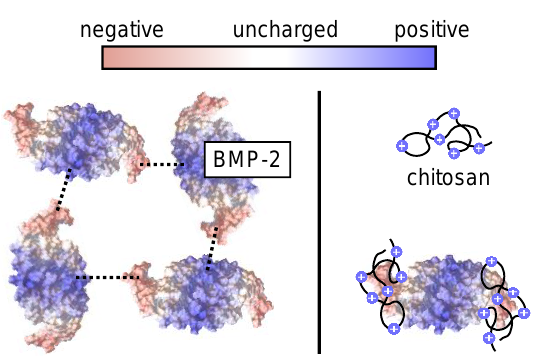
Figure 9. Schematic presentation of the proposed effect of chitosan on the aggregation tendency of BMP-2. Left (without chitosan): Ionic BMP-2 self-interaction, leading to BMP-2 aggregation [23]. Right: Binding of chitosan to the negatively charged tips of BMP-2 [27], potentially leading to a decreased aggregation tendency.